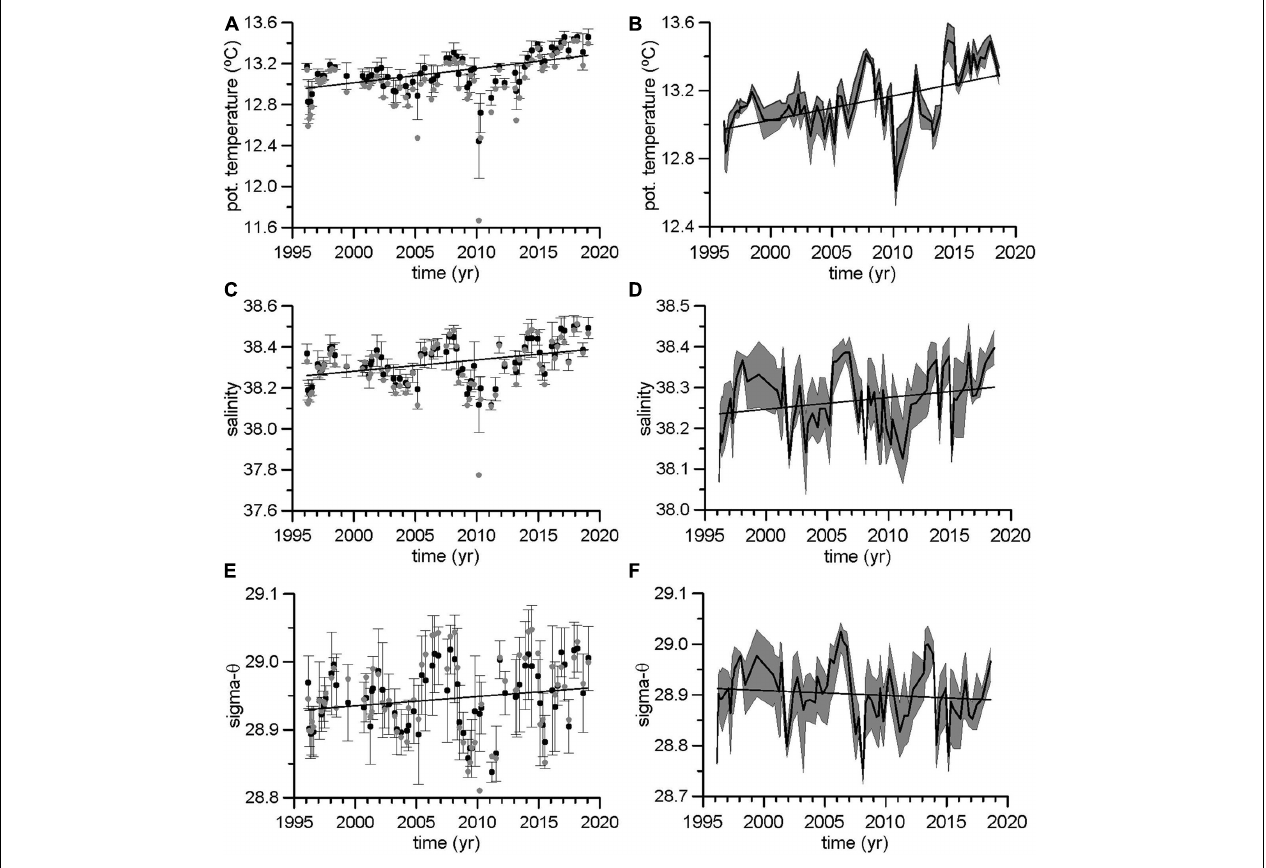
FIGURE 4 | Time series for the potential temperature (A,B) , salinity (C,D) , and potential density (E,F) for the WIW. Black dots in (A,C,E) correspond to the WIW properties obtained using method 1. Error bars for this method represent one standard deviation. Gray dots correspond to method 2. (B,D,F) Show the WIW properties obtained using the geometric method in Juza et al. (2019). Black lines represent the 50th percentile and the shaded areas correspond to the 17th and 83rd